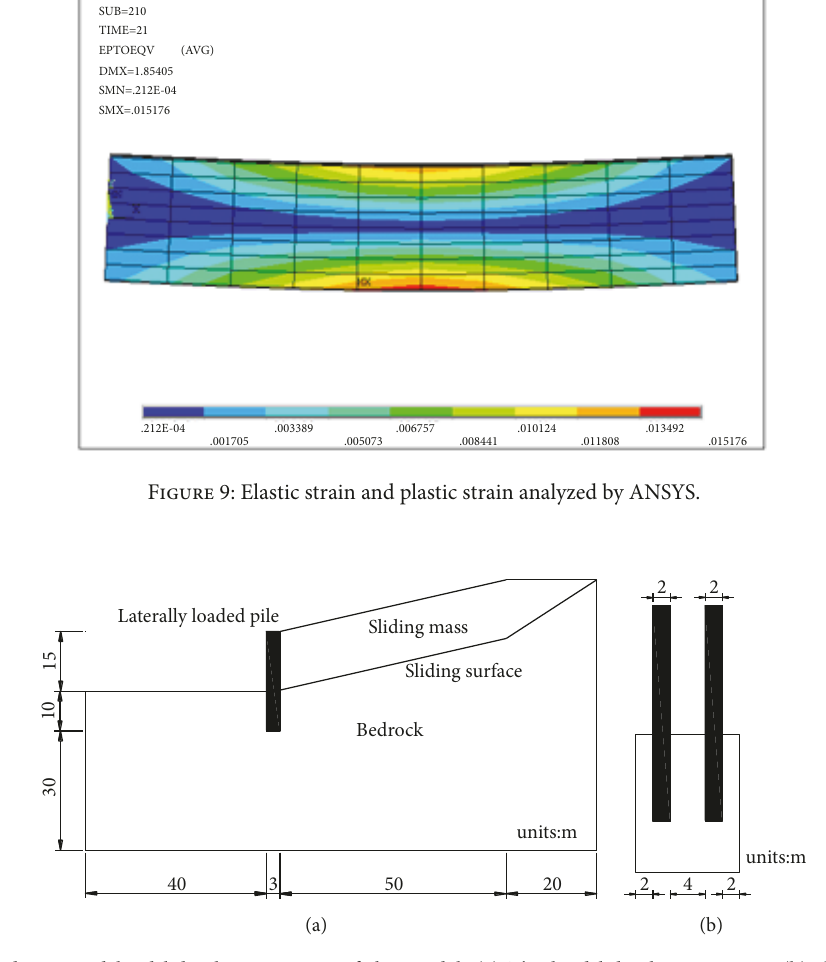
Figure 10: Structural design and landslide characteristics of the model. (a) The landslide characteristics; (b) the design parameters of stabilizing